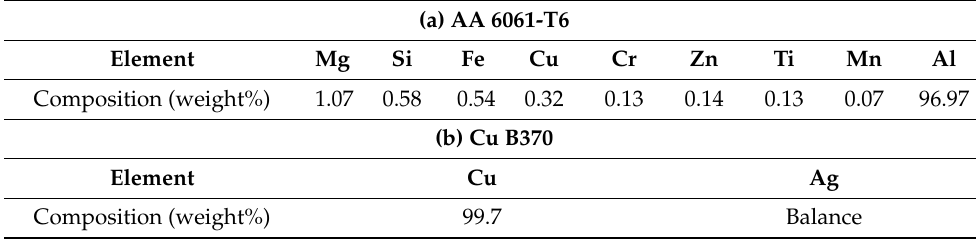
Table 1. Chemical composition.